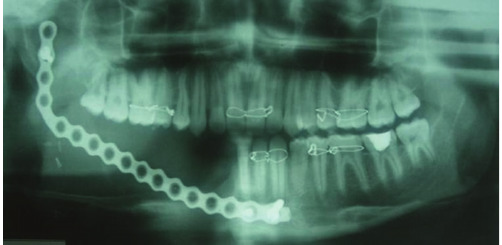
Figure 7: Postoperative panoramic radiograph showing recon- struction of the resected site with microvascular iliac bone grafting and fixation with titanium